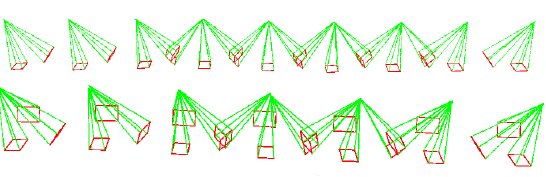
Figure 5: Detail of the relative oriented camera positions in the space.